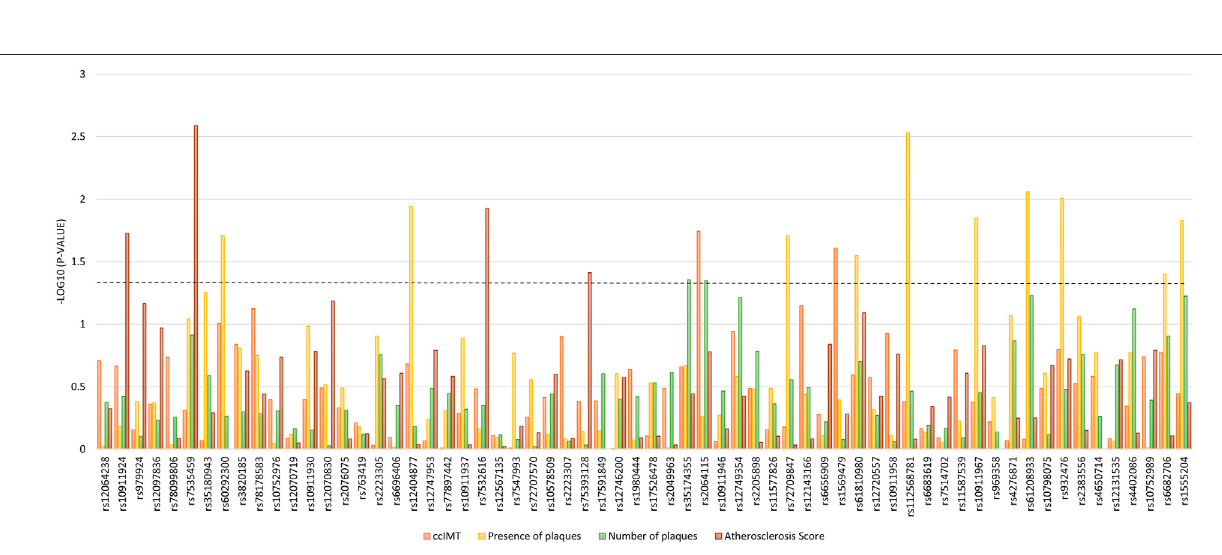
Frontiers in Pharmacology |